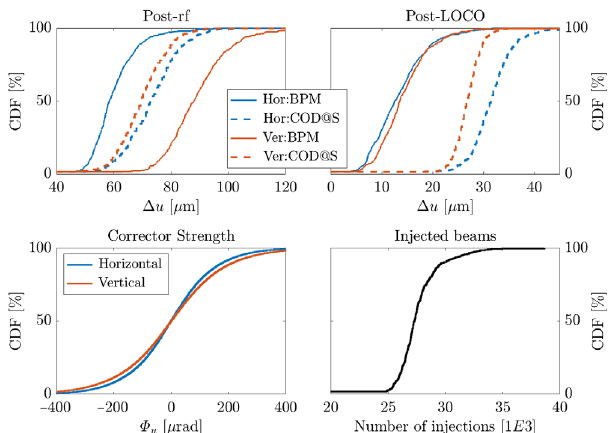
FIG. 13. Machine status after applying final orbit correction. The lower plots show the CDFs of the number of required beam injections (right) and the required corrector strength (left) of all CMs of all error seeds. The upper plots show the rms value of the BPM readings (solid) and COD in SF/SD magnets (dashed) before and after applying three iterations of Secs, IV F – IV H (rms over each error